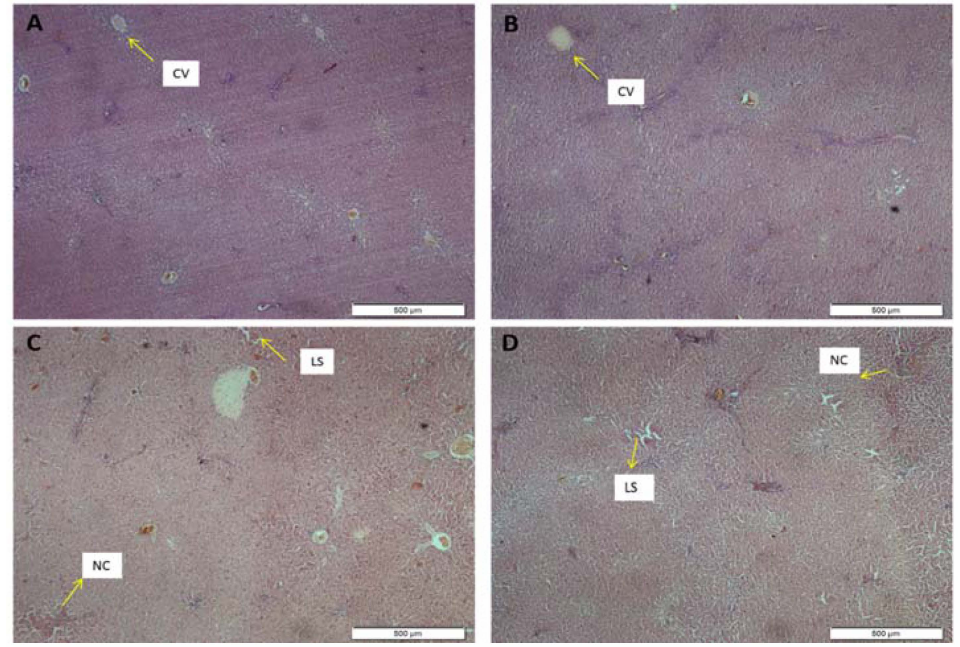
Figure 4. Liver sections stained with hematoxylin and eosin (H & E-stained under 40 ˆ magnification power) showing the effect of Alstonia scholaris methanolic extract (ASME) in a 28-day sub-acute toxicity study in male rats: ( A ) Control group; ( B ) 250 mg/kg; ( C ) 500 mg/kg and ( D ) 1000 mg/kg. Indicators: Portal Triad (PT); Central Vein (CV); Centrilobular Necrosis